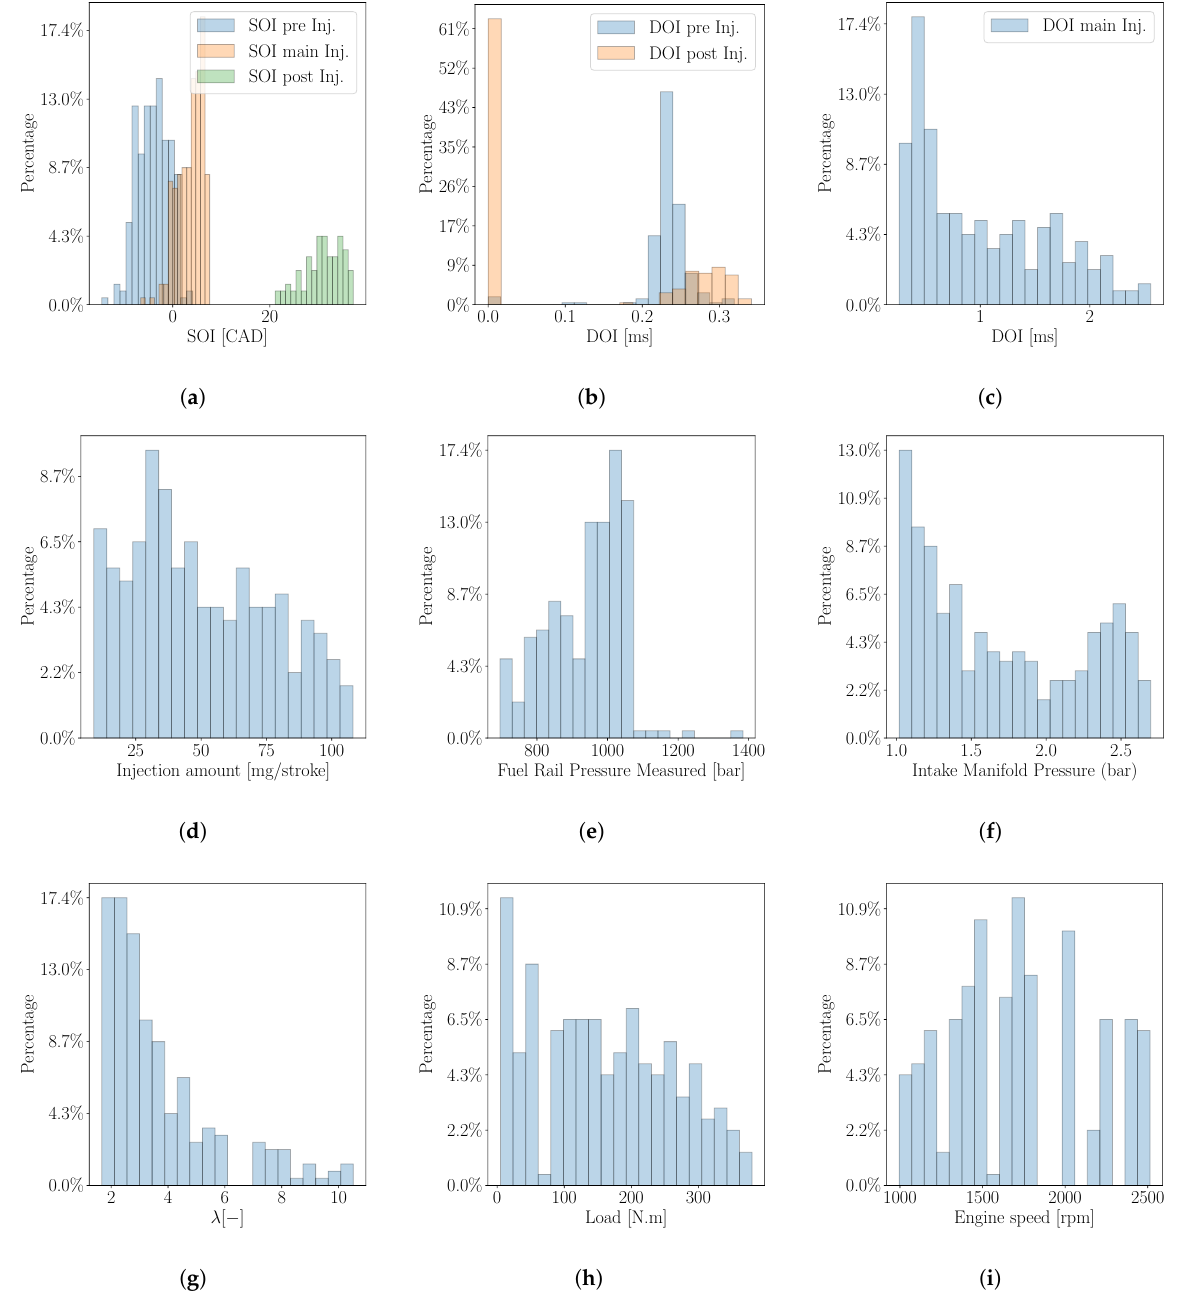
Figure 3. Histogram of diesel engine main experimental features. ( a ) Start of Injection (SOI). ( b ) Duration of Injection (DOI). ( c ) Duration of main injection. ( d ) Injected fuel amount per cycle. ( e ) Fuel rail pressure. ( f ) Intake manifold pressure. ( g ) Air-fuel equivalence ratio ( λ ). ( h ) Output torque (load). ( i ) Engine